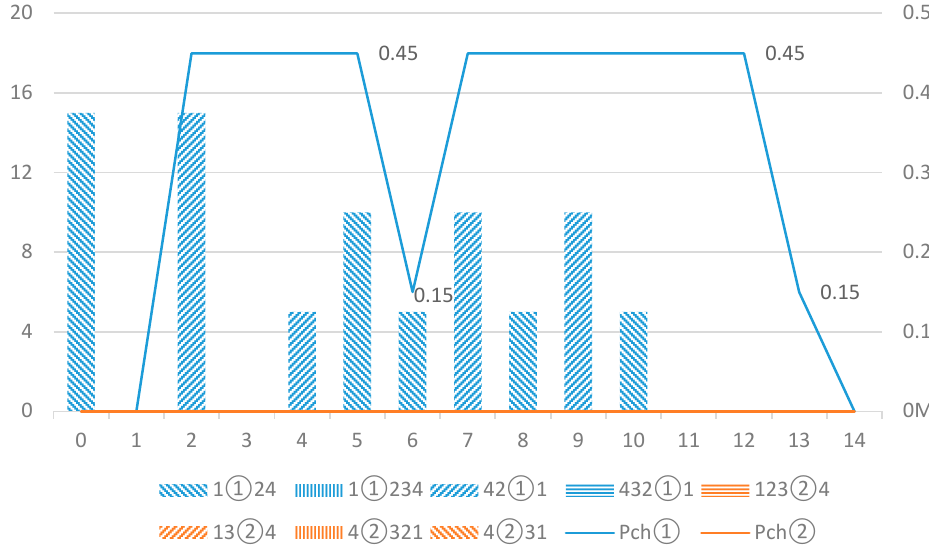
( b ) Figure 9. ( a ) Instantaneous flow rate of task 1 for time period 0 to 10 under TN prior; ( b ) instanta- neous flow rate of task 2 for time period 4 to 14 under TN prior. (G represents GV, E represents EV, 14 and 41 are O–D pairs, r represents departing flow, and s represents arriving flow).